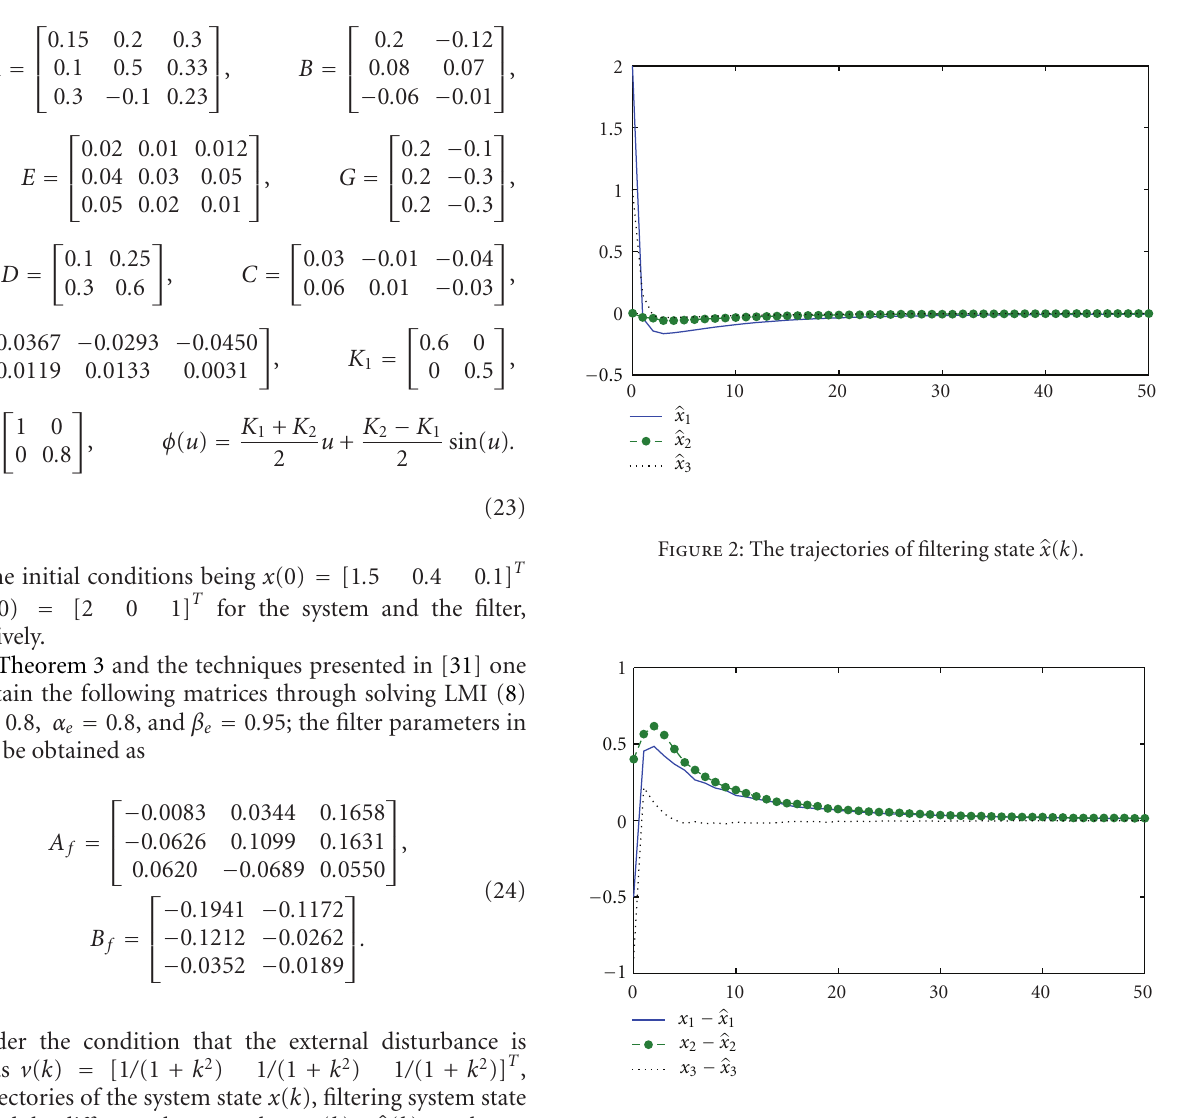
Figure 3: The trajectories of x ( k ) − (cid:16) x ( k